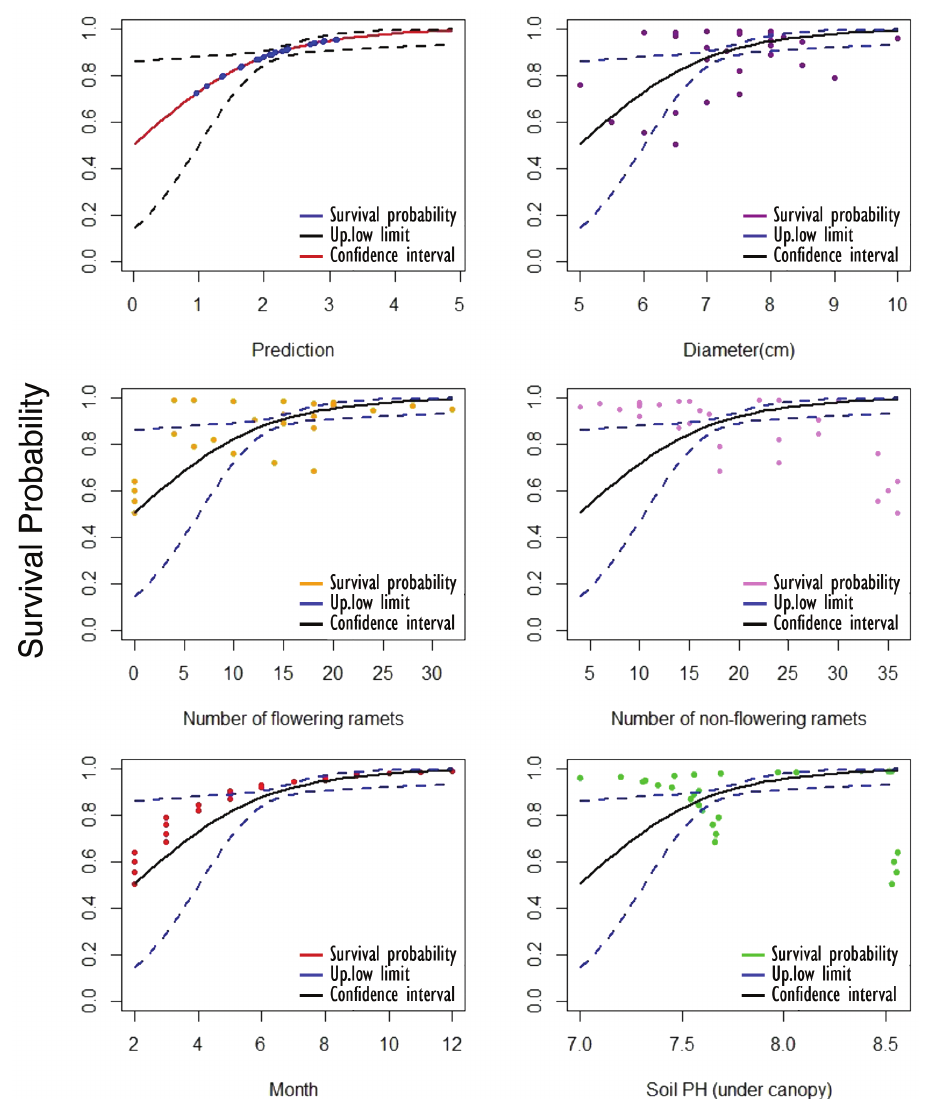
Figure 4. The relationship between survival probability and predictors from the top model for Roadside